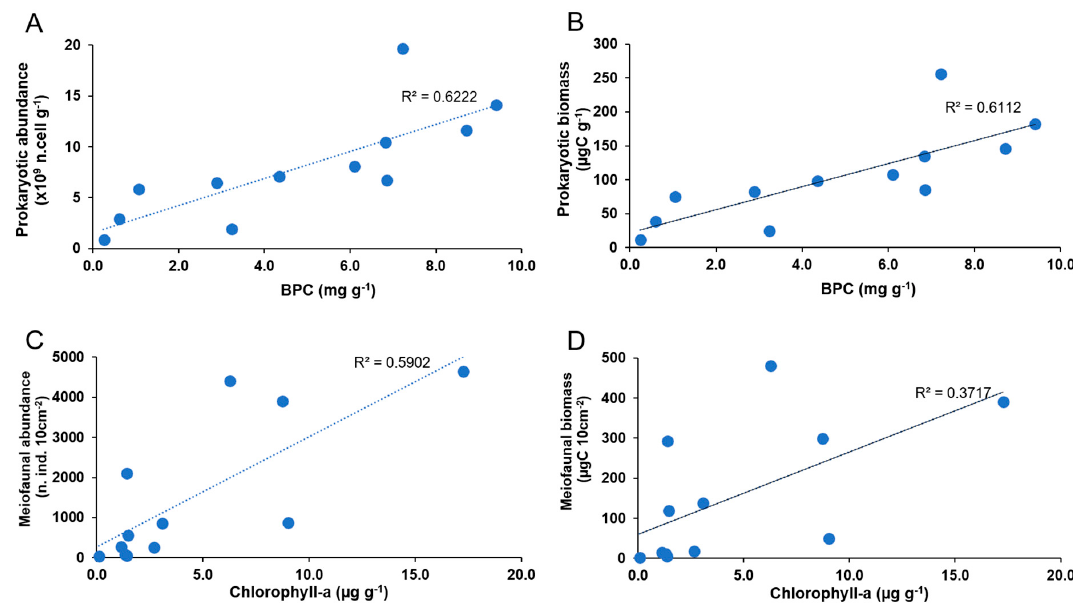
Figure 5. Relationships between biopolymeric C contents and prokaryotic abundance ( A ) and biomass ( B ), as well as between chlorophyll-a and meiofauna abundance ( C ) and biomass ( D ) in the sediments. Table 3. Results of the multivariate multiple regression analysis carried out to ascertain the effect of the quantity and nutritional quality of sedimentary organic matter on the prokaryotic OTU composition ( A ) and meiofaunal taxonomic composition irrespective of the season ( B ), in summer, ( C ) and in winter ( D ). % Variance = percentage of explained variance (SS = sum of squares; F = F statistic; P = probability level; *** = P < 0.001; ** = P < 0.01; * = P < 0.05; ns = not